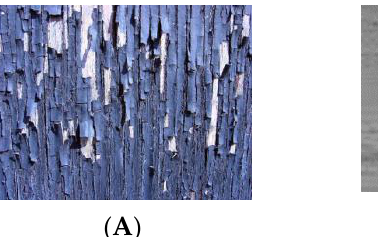
Figure 17. Paint failure due to surface moisture sorption ( A ) and paint failure due to end grain moisture sorption ( B ).